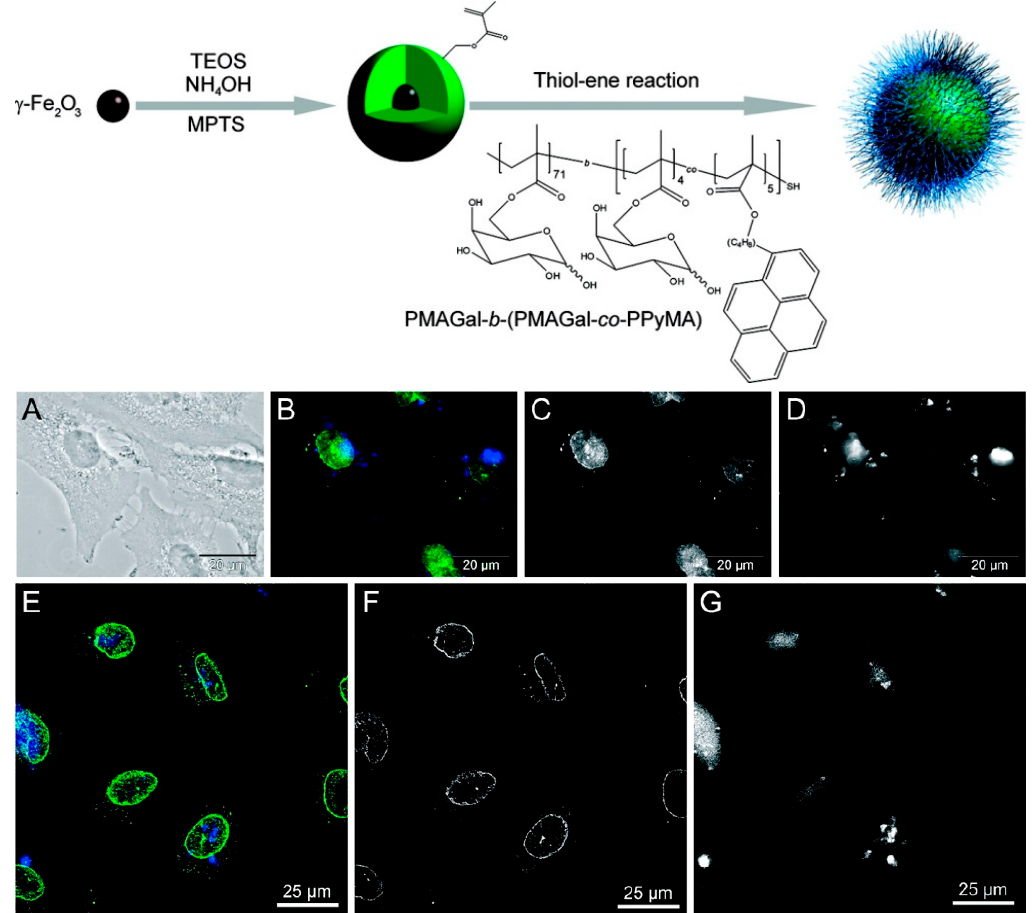
Figure 3. Synthesis of Fluorescent, Magnetic, Glycopolymer-Grafted Nanoparticles and Microscope images of A549 cells exposed to glycopolymer-grafted nanoparticles. ( A – D ) epifluorescence microscopy, ( E – G ) confocal microscopy. ( A ) Transmission image, ( B , E ) merged fluorescence images, ( C , F ) fluorescence images that exclusively show the green light emitting structures in the cell (nuclear membrane), and ( D , G ) fluorescence images that exclusively show the blue light emitting structures (pyrene in the glycocopolymer covered nanospheres). Adapted from ref. [38].